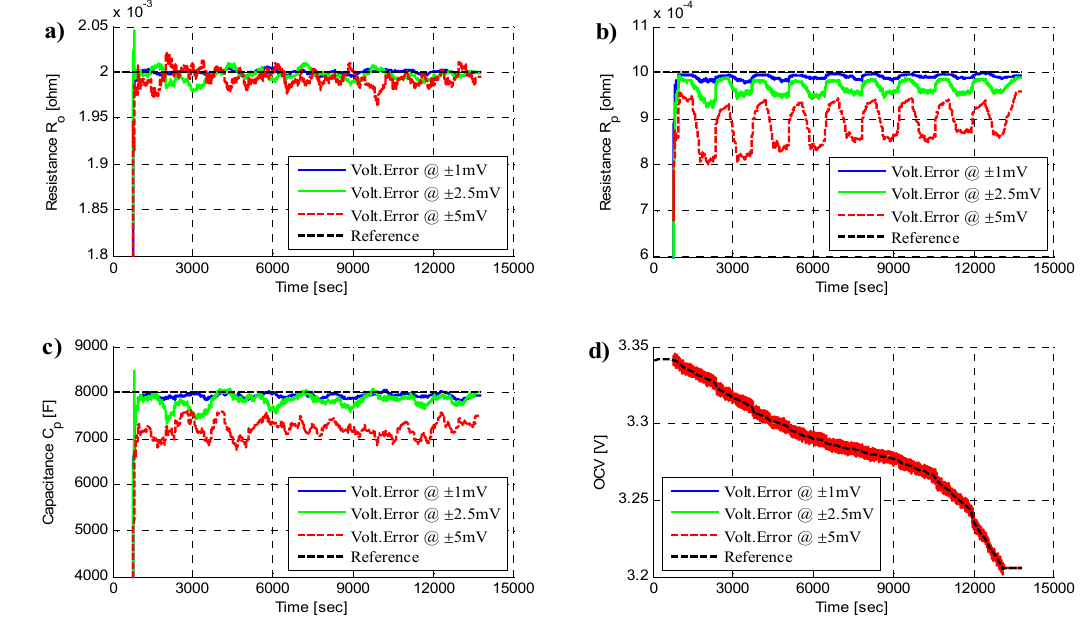
Figure 10. Estimated parameters: ( a ) R o , ( b ) R p , ( c ) C p , and ( d ) OCV at the voltage sensor precisions of ±1/±2.5/±5